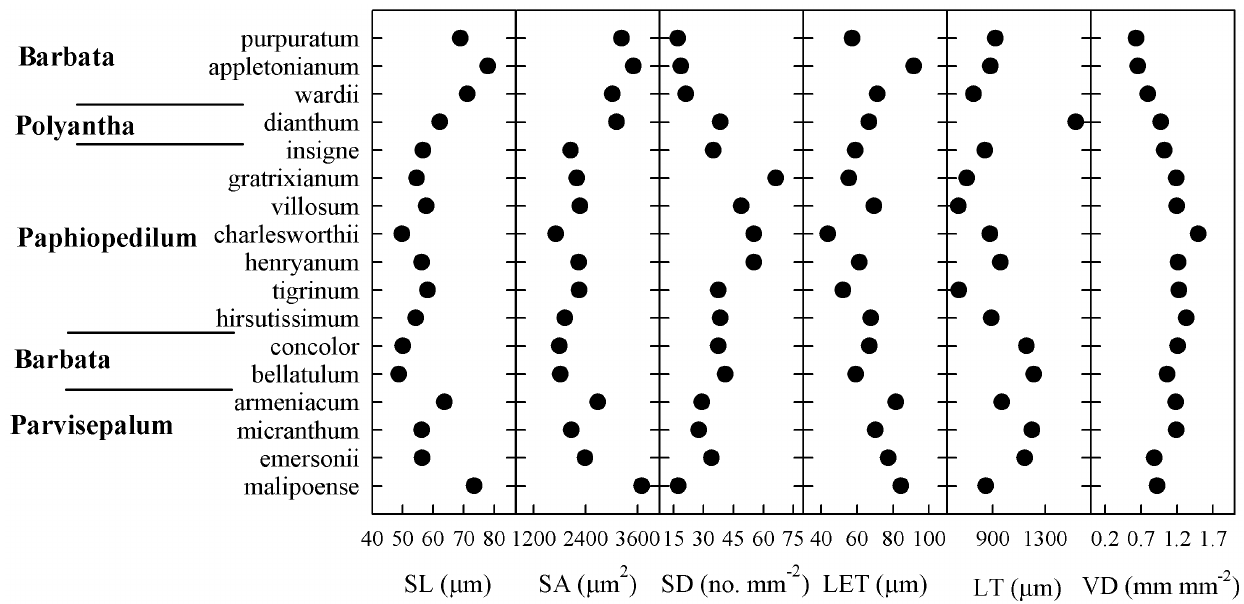
Figure 1. Values for leaf traits and stomatal straits in Paphiopedilum species. SL, stomatal length; SA, stomatal area; SD, stomatal density; LET, lower epidermal thickness; LT, leaf thickness; and VD, vein density. Names of subgenera are at left, and are based upon nuclear rDNA ITS trees from Cox et al . [46].